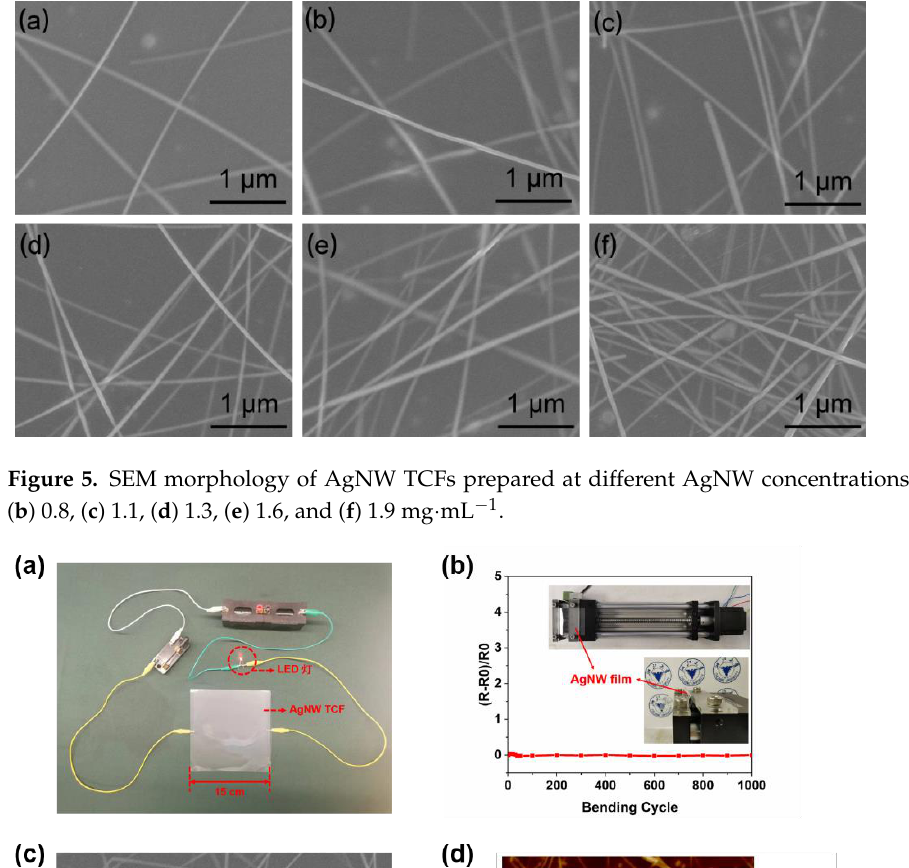
Figure 5. SEM morphology of AgNW TCFs prepared at different AgNW concentrations: ( a ) 0.5, ( b ) 0.8, ( c ) 1.1, ( d ) 1.3, ( e ) 1.6, and ( f ) 1.9 mg·mL −1 .